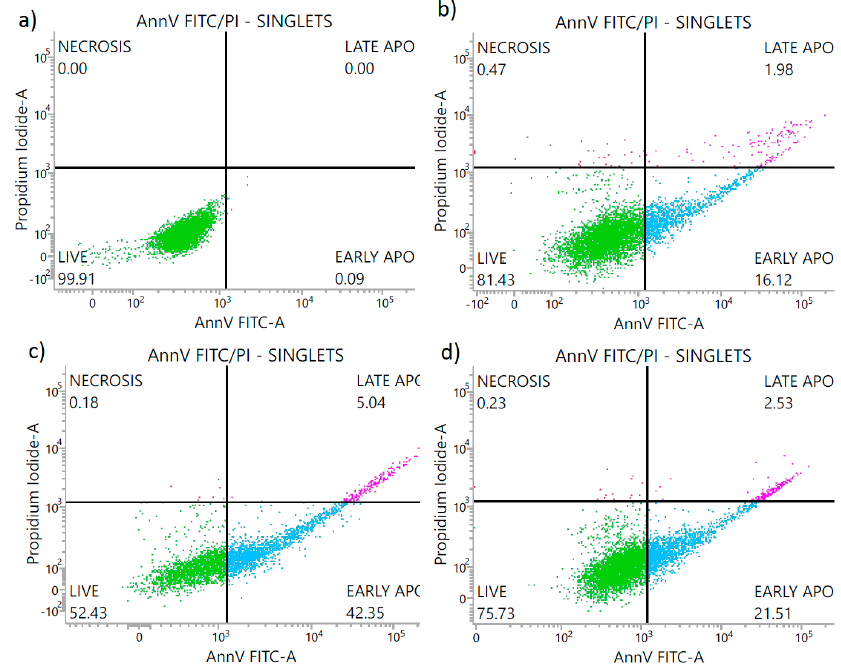
Figure 7. Percentage share of the L929 cells: alive, early apoptotic, late apoptotic and necrotic after 24 h treatment with: ( a ) DMEM—control group; ( b ) 4 h extract of pure PA12; ( c ) 4 h extract of PA12 with 3 wt % of metal oxides; ( d ) 4 h extract of PA12 with 4 wt % of metal oxides. The experiment was performed in triplicate.